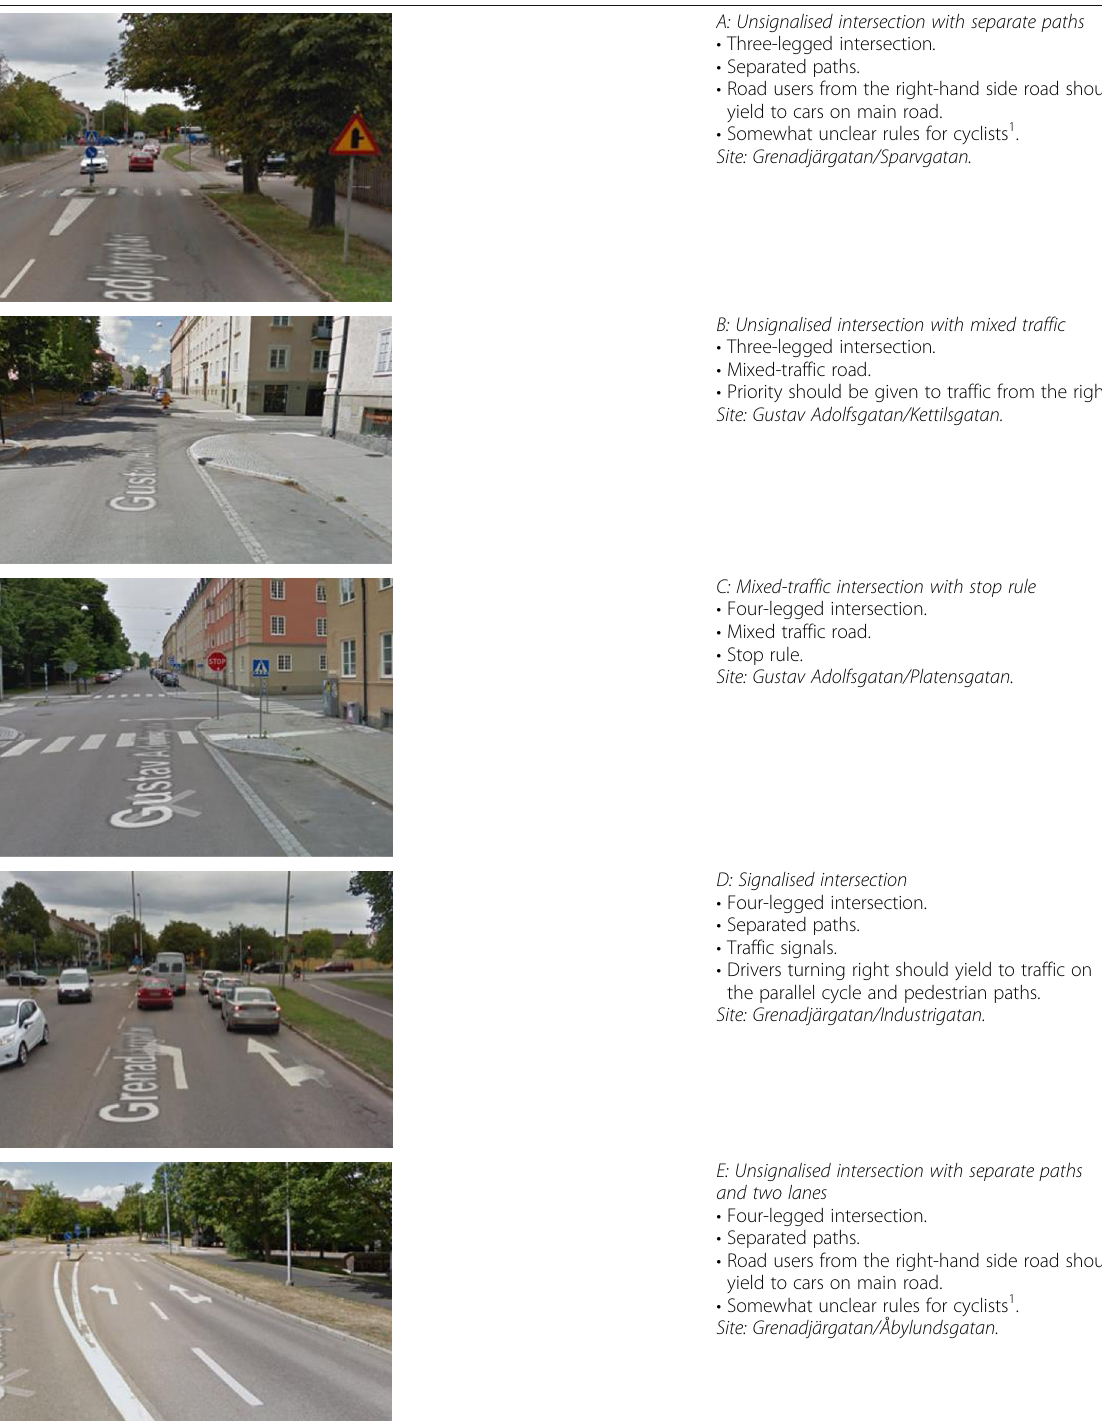
Table 3 Intersections analysed in the study. A: Unsignalised intersection with separate paths. B: Unsignalised intersection with mixed traffic. C: Mixed-traffic intersection with stop rule. D: Signalised intersection. E. Unsignalised intersection with separated paths and two lanes. Photos: Google “ Streetview ” , digital images, Google Maps (http://google.com), taken in Linköping, Sweden, between June 2014 and August 2018, viewed on 12 June 2019